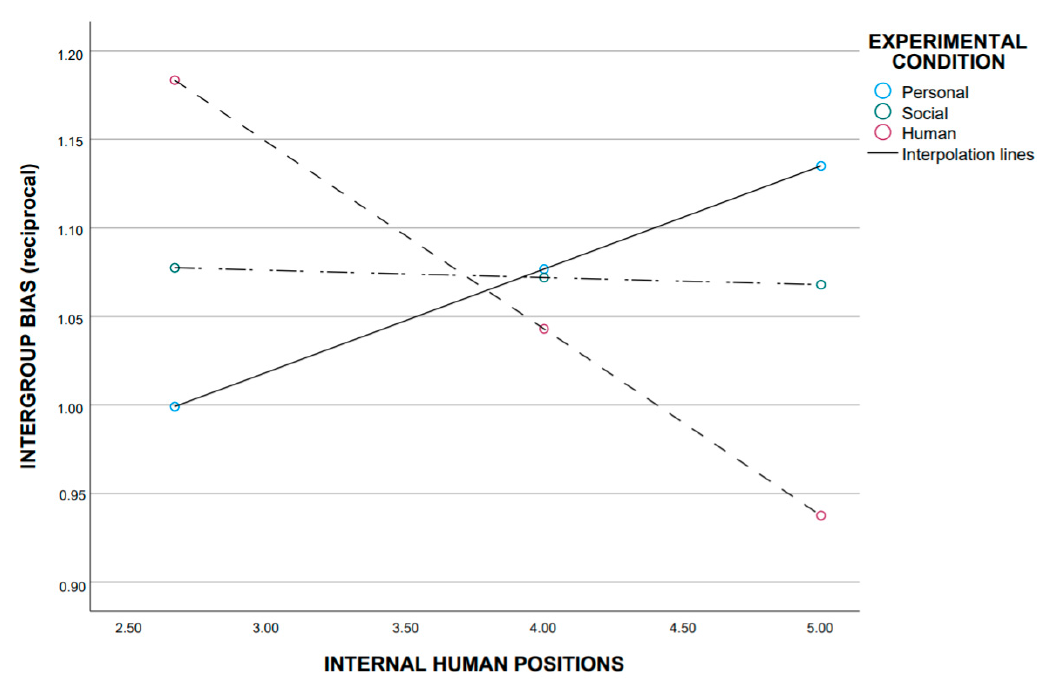
Figure 3. Scatterplot of the relations between internal human positions’ salience and intergroup bias (reciprocal) for each experimental condition. Note: experimental condition 1 = personal level of inclusiveness; experimental condition 2 = social level of inclusiveness; and experimental condition 3 = human level of inclusiveness.